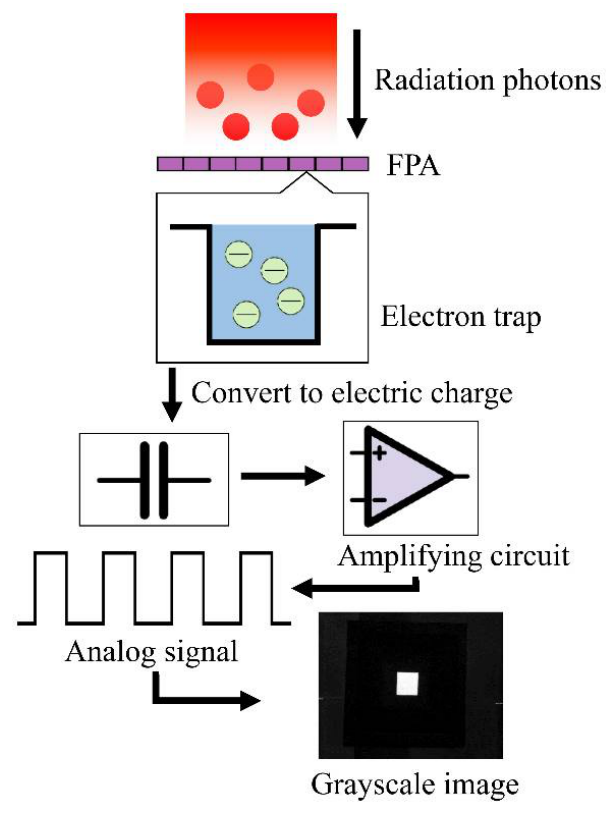
Figure 1. Physical model of the linear response process of the detector.